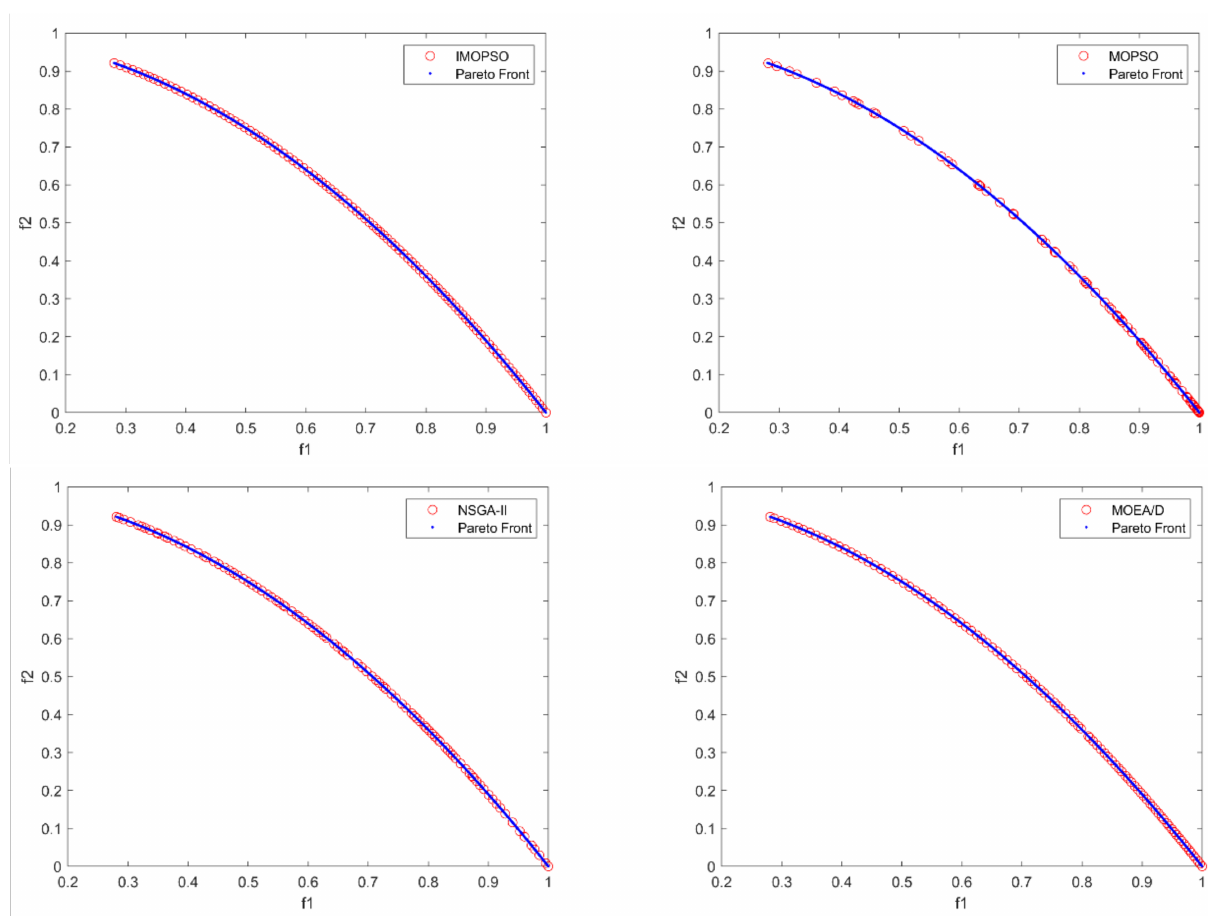
Figure 12. Comparison of the results of four algorithms for solving ZDT6